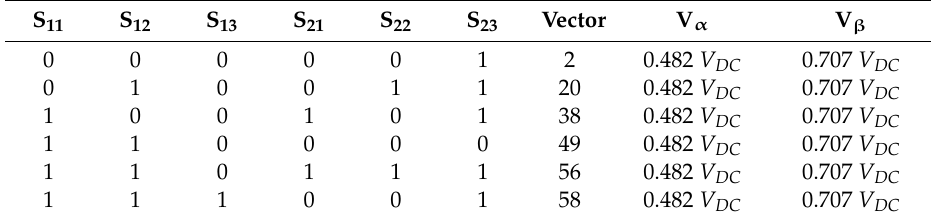
Table 2. Combination and applied voltage for V DC 1 = V DC 2